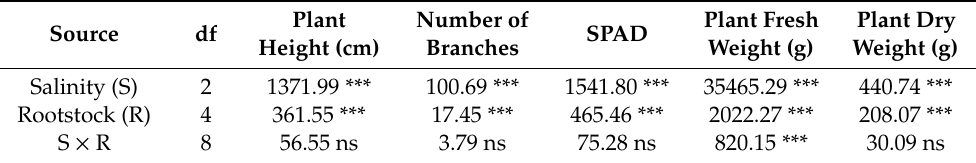
Table 5. Analysis of variance (mean square) of tomato growth attributes.